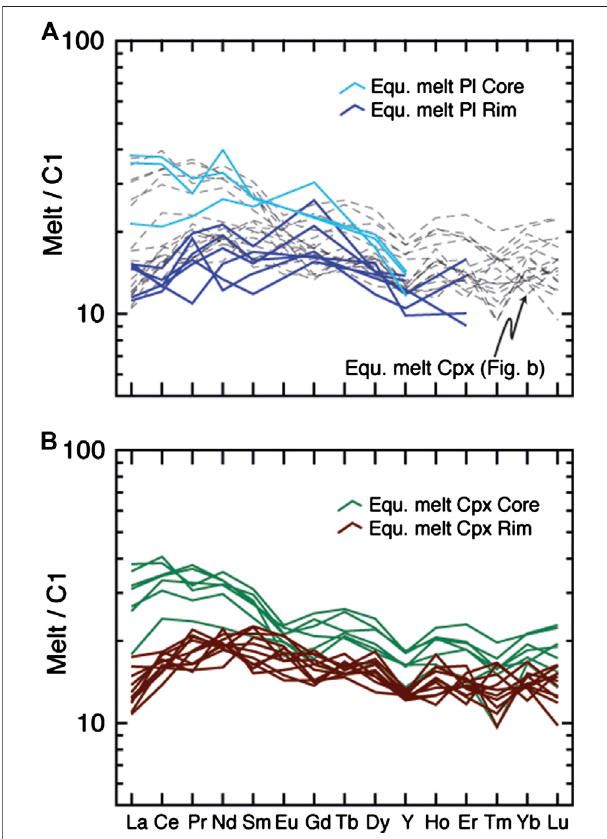
FIGURE 10 | Chondrite (C1)-normalized (Anders and Ebihara, 1982) REE patterns of computed melts in equilibrium with (A) plagioclase (PL) and (B) and clinopyroxene (Cpx) at each point of the chemical transects in Figure 9 . Melts in equilibrium with Cpx are also shown in A as dashed gray lines for comparative purposes. Core and rim compositions are distinguished as indicated in Figure 4 and show a very good consistency.